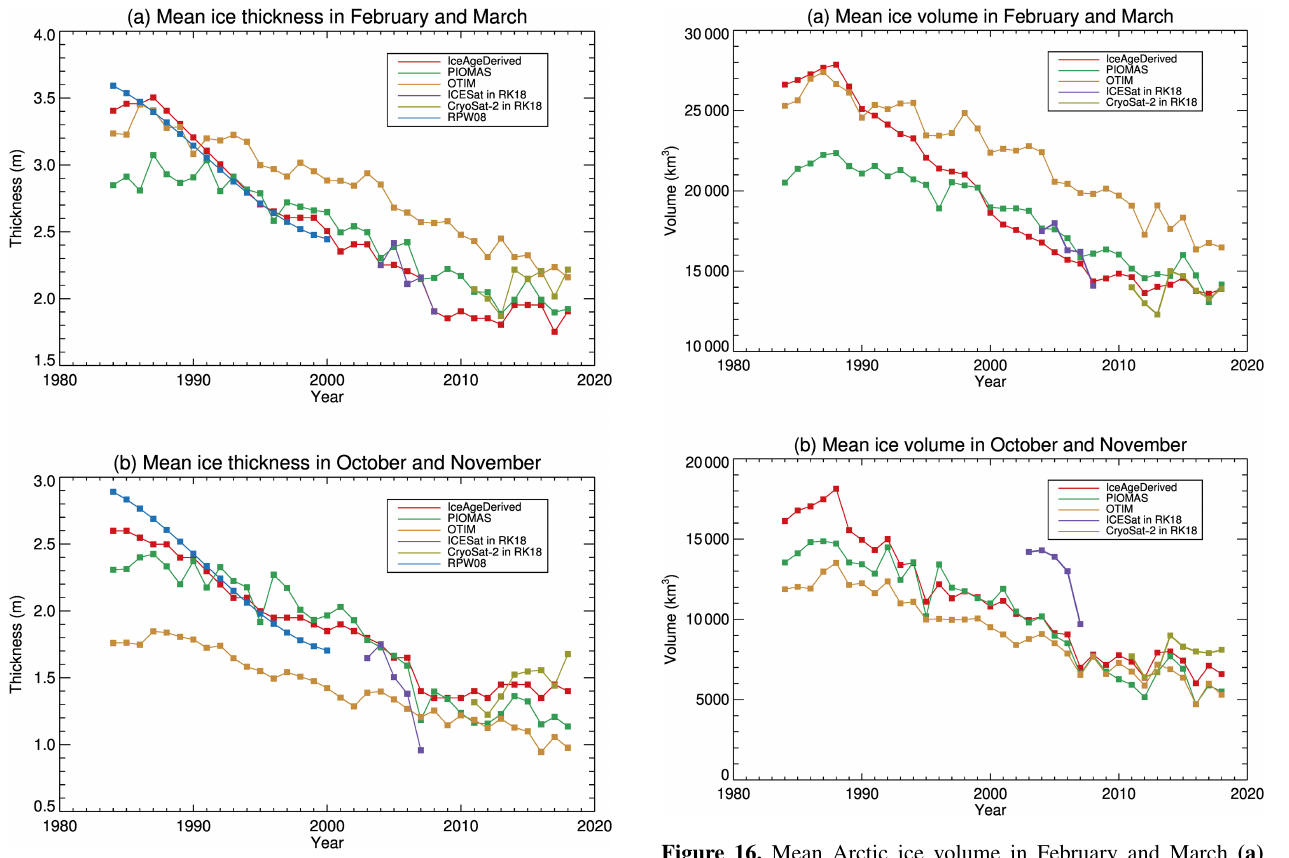
table differences. The similarities prove the soundness of the ice aged-based ice thickness and ice volume dataset, while the differences indicate there is room for further improve- ment in all the ice thickness